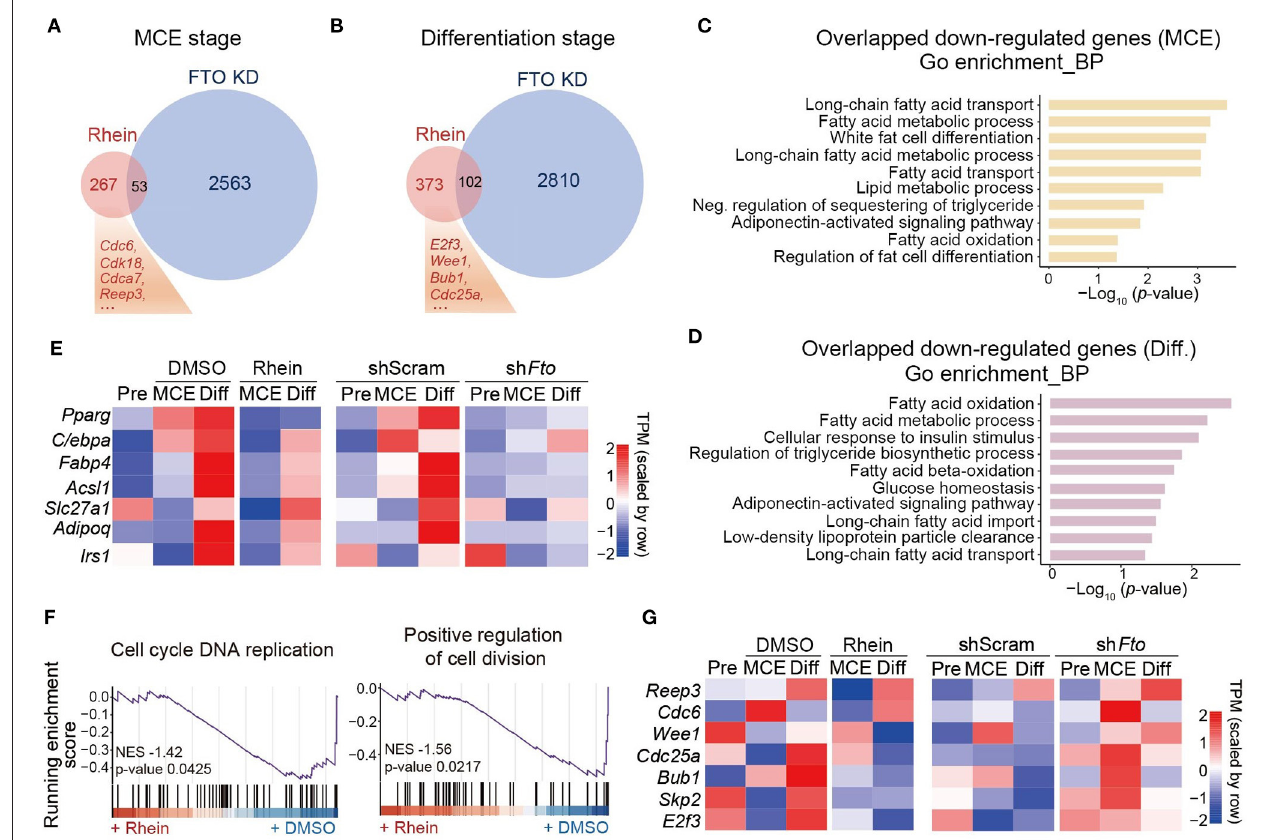
FIGURE 2 | Comparative transcriptome analysis of effects of rhein treatment and fat mass and obesity-associated ( Fto ) depletion on adipogenesis. (A) Venn diagram showing the overlap of downregulated genes in cells lacking Fto or treated with rhein at the MCE stage. (B) Venn diagram showing the overlap of downregulated genes in cells lacking Fto or treated with rhein at the differentiation stage. (C,D) The Gene Ontology (GO) analysis of common downregulated genes in rhein-treated and sh Fto cells collected at the MCE stage or the differentiation stage. (E) Heatmap showing expression of genes responsible for adipocyte formation in rhein-treated cells and Fto knockdown cells at the distinct stages. (F) The gene set enrichment analysis plots for rhein-regulated genes, as determined by RNA-seq. (G) Heatmap showing expression of genes responsible for mitosis in rhein-treated and sh Fto cells at the distinct stages.